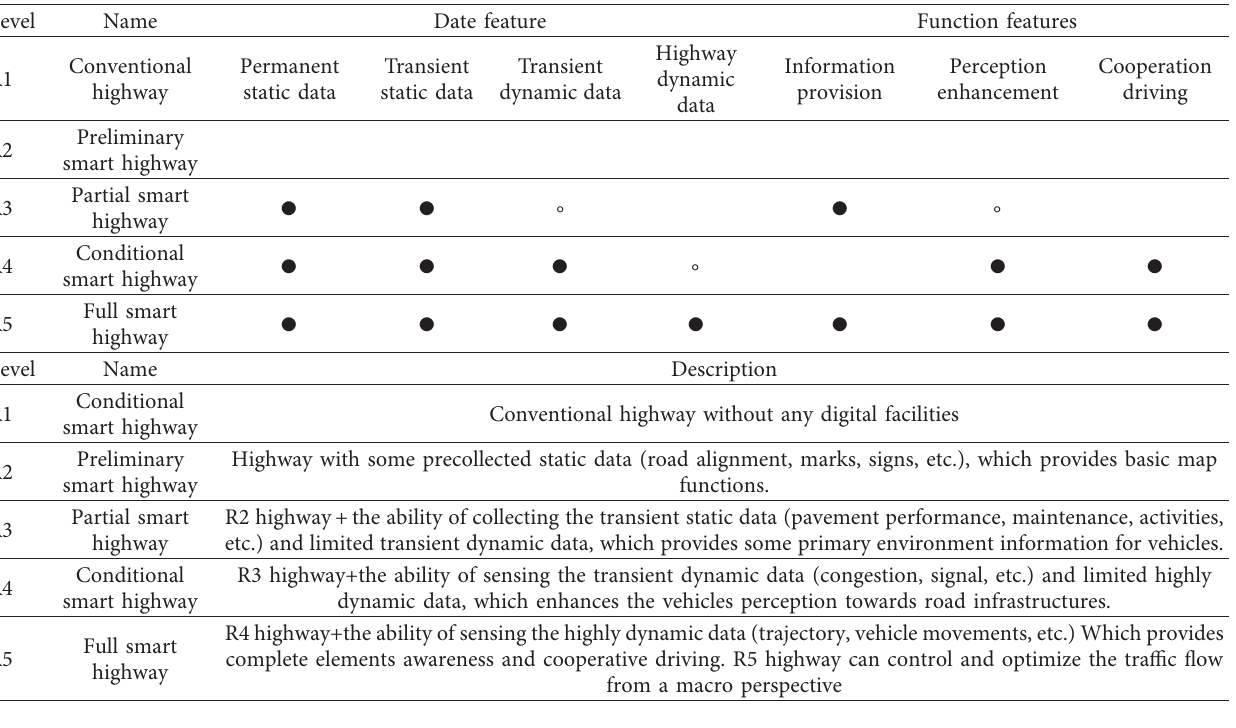
Table 3: Smart levels of the new generation of smart highway.